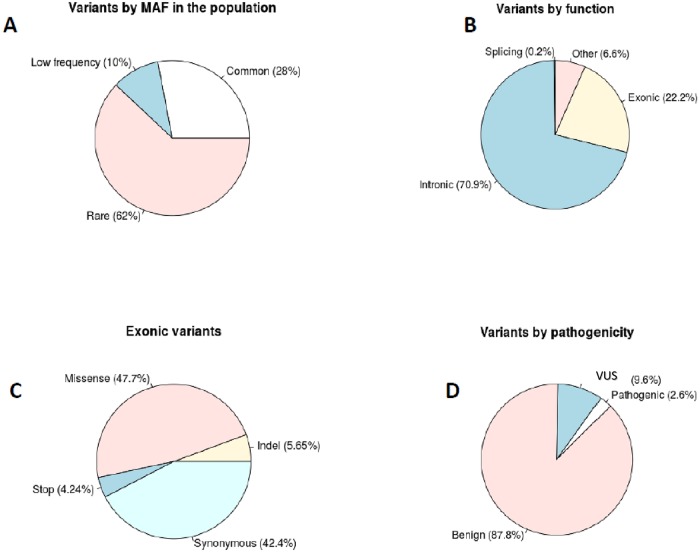
Description of the genetic variability.Distribution of genetic variants considering Minor Allele Frequency (MAF) (A), considering their genomic function (B), based on exonic type (C), considering their clinical classification (D).